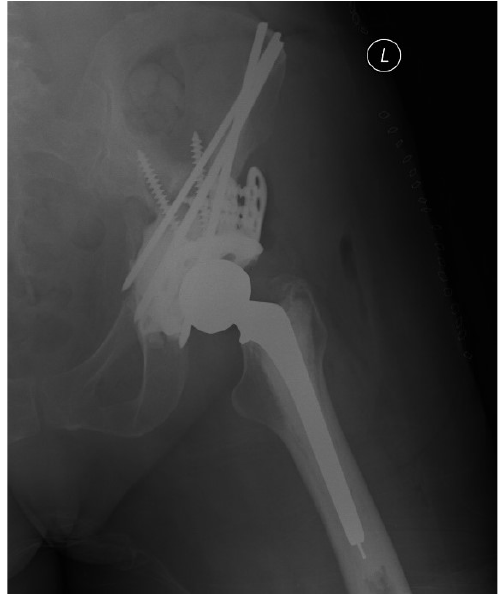
Figure 1. Traditional Harrington Procedure with superior titanium acetabular augmentation.